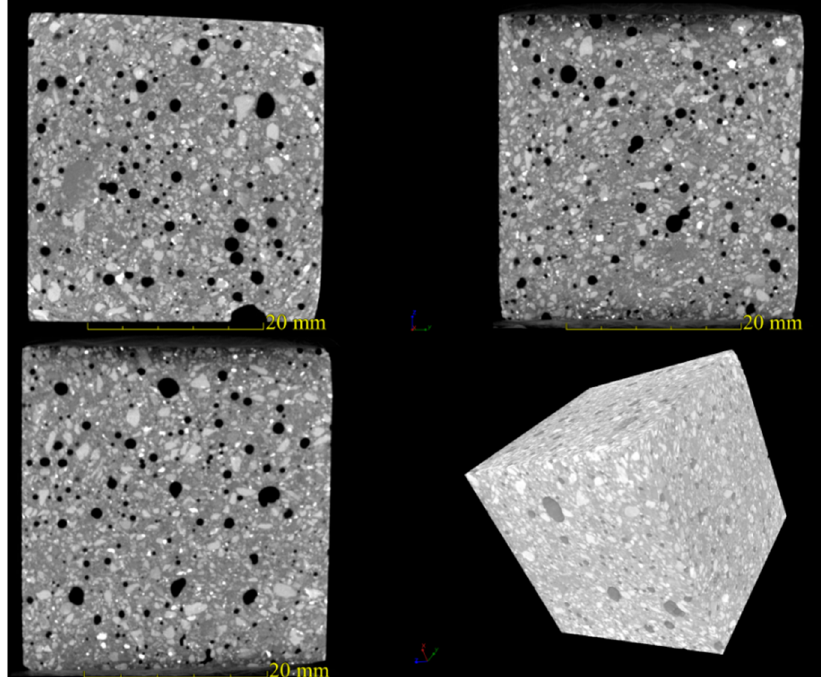
Figure 9. Four views of AACM specimen.